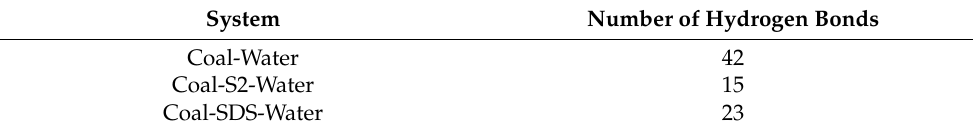
Table 4. Number of hydrogen bonds in water-surfactant-coal models and water-coal model.